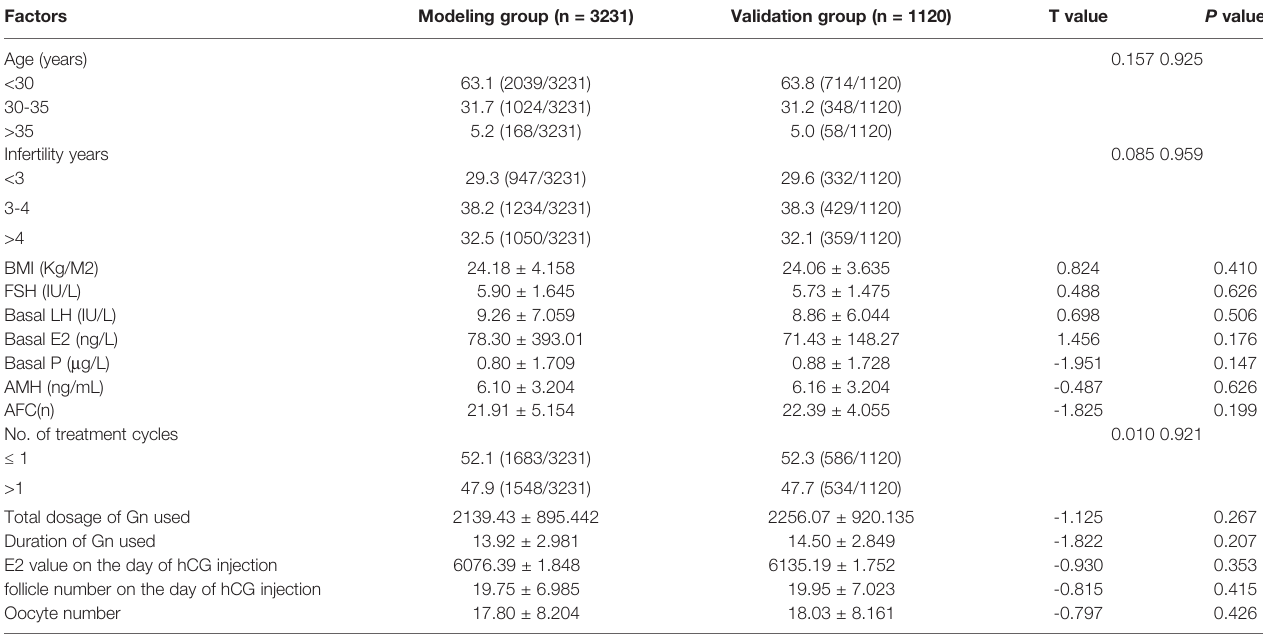
TABLE 3 | Baseline characteristics of patients in the modeling and validation groups.